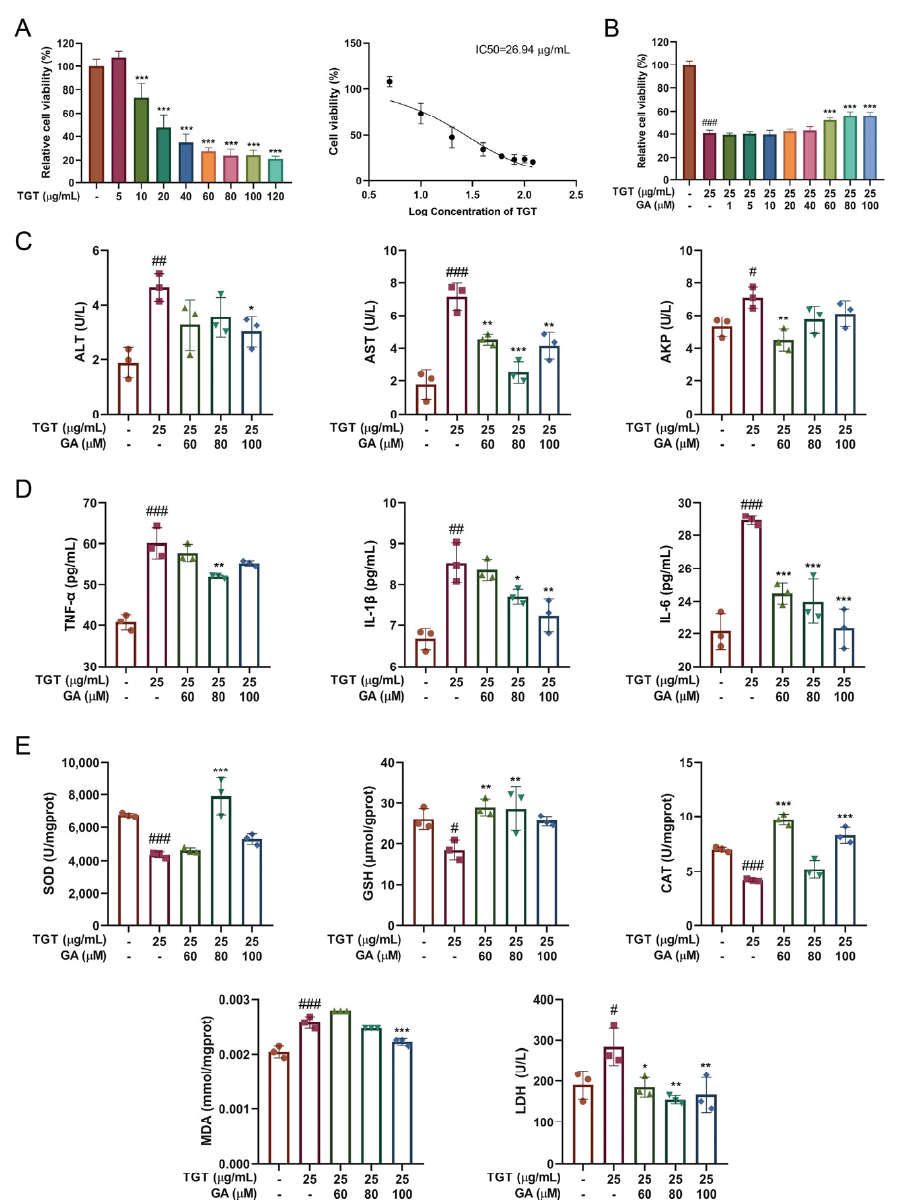
Figure 2. Influence of GA on liver function, oxidative stress indicators and inflammatory cytokines in vitro. ( A ) Effects of TGT on the viability of BRL-3A cells, n = 3; ( B ) influence of GA on the viability of BRL-3A cells, n = 3; ( C ) effects of GA on ALT, AST and AKP in the supernatant of BRL-3A cells, n = 3; ( D ) effects of GA on release of inflammatory cytokines TNF- α , IL-1 β and IL-6, n = 3; ( E ) effects of GA on SOD, GSH, CAT, MDA and LDH. Data are expressed as the mean ± s; # p < 0.05, ## p < 0.01, ### p < 0.001 vs. control; * p < 0.05, ** p < 0.01, *** p < 0.001 vs. model.